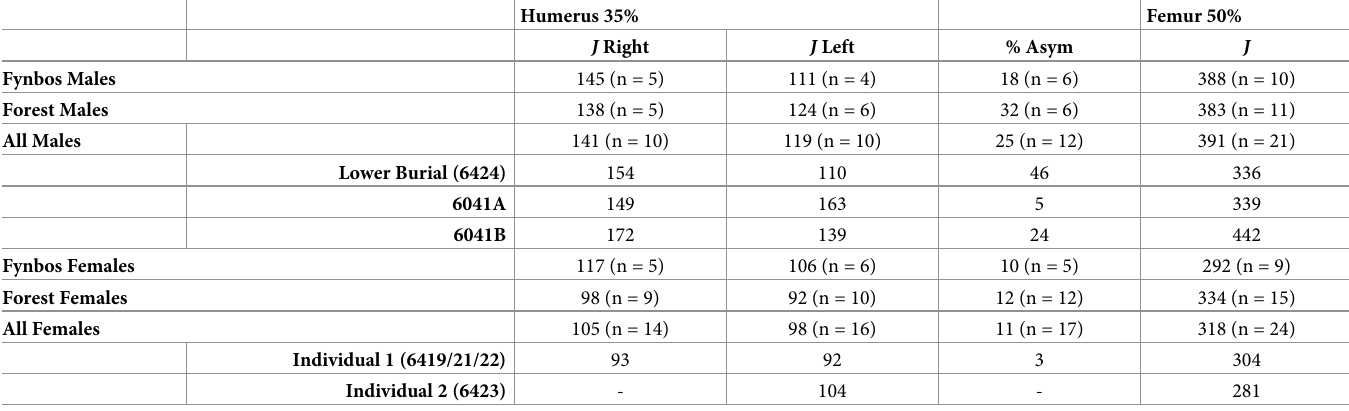
Table 4. Cross-sectional geometric properties of Lagoon Beach adults, compared to mean values of Later Stone Age adults of the fynbos and forest biomes (as per 57). Values of J for distal humerus shaft and mid-shaft femur are body-size-standardized as (body mass � bone length) 2 � 10 5 [56]; humerus asymmetry is absolute value of unstandardized J .